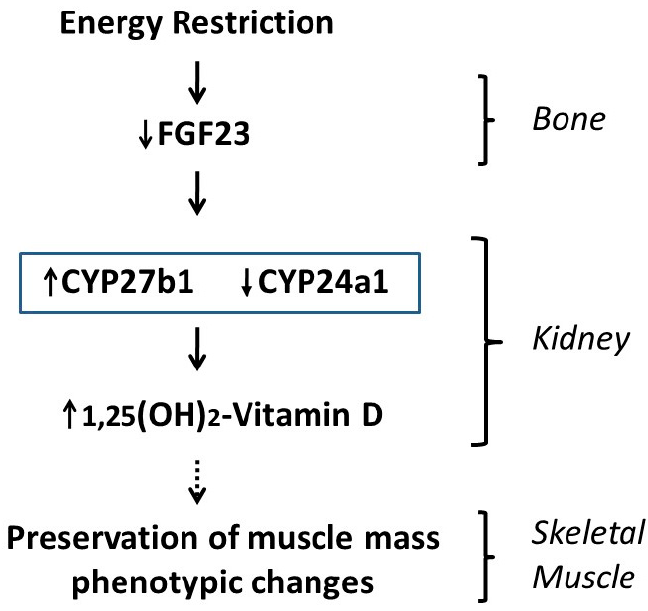
Figure 7. Proposed mechanism by which energy restriction modulates skeletal muscle mass and phenotype through regulation of vitamin D metabolism.